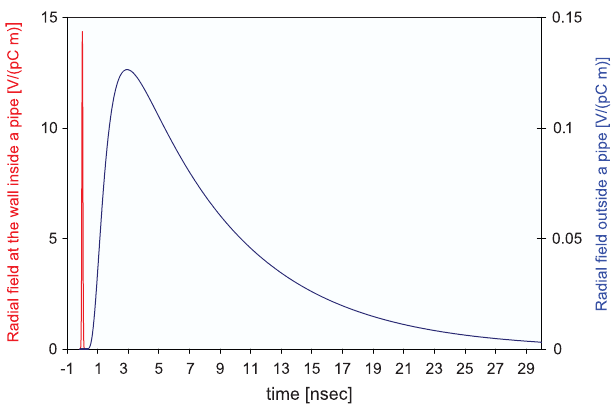
FIG. 1. (Color) The radial component of the E field on the inner (red line) and outer (blue line) sides of a beam pipe. Scales for the fields are on the left and right plot